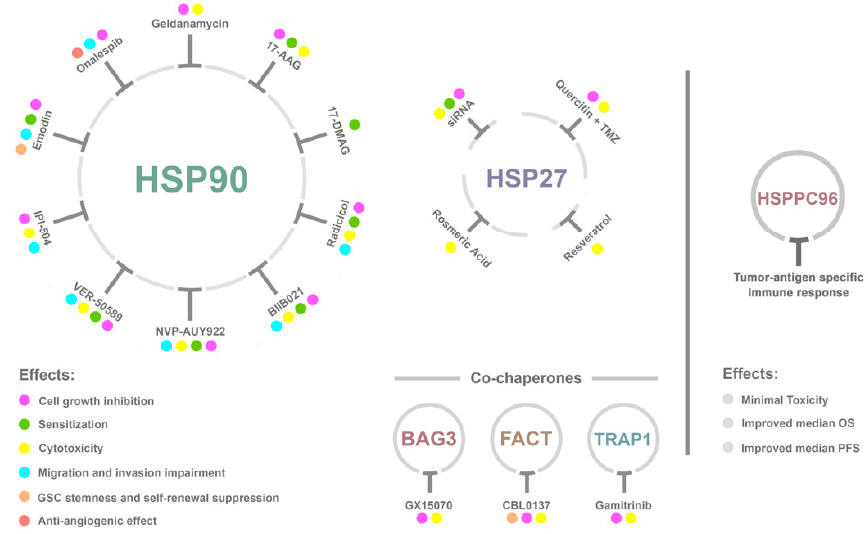
Figure 2. Heat shock proteins (HSPs) targeted for distinct therapeutic approaches anti-GBM. New strategies involve the use of active immunotherapy and HSP-targeting drugs. The most abundant are HSP90 and HSP27 inhibitors, with a few examples of molecules against co-chaperones. The main e ff ects elicited by HSP inhibitors on GBM are cell growth inhibition, radio- and / or chemo-sensitization, cytotoxicity, migration and invasion impairment, glioma stem cells (GSCs) stemness and self-renewal suppression, and anti-angiogenic e ff ect. Vaccines against GBM target the heat shock protein–peptide complex-96 (HSPPC-96) and clinical trials demonstrate that the vaccination causes a tumor antigen-specificimmuneresponseonthehost, withminimaltoxicityandimprovementofmedianoverall survival (OS) and median progression-free survival (PFS). Abbreviations: 17-AAG,